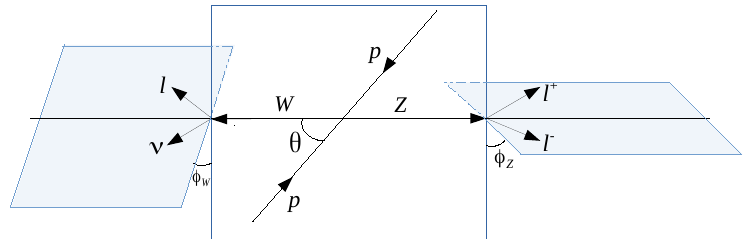
Figure 2 . Angles for 2 ! 4 scattering.